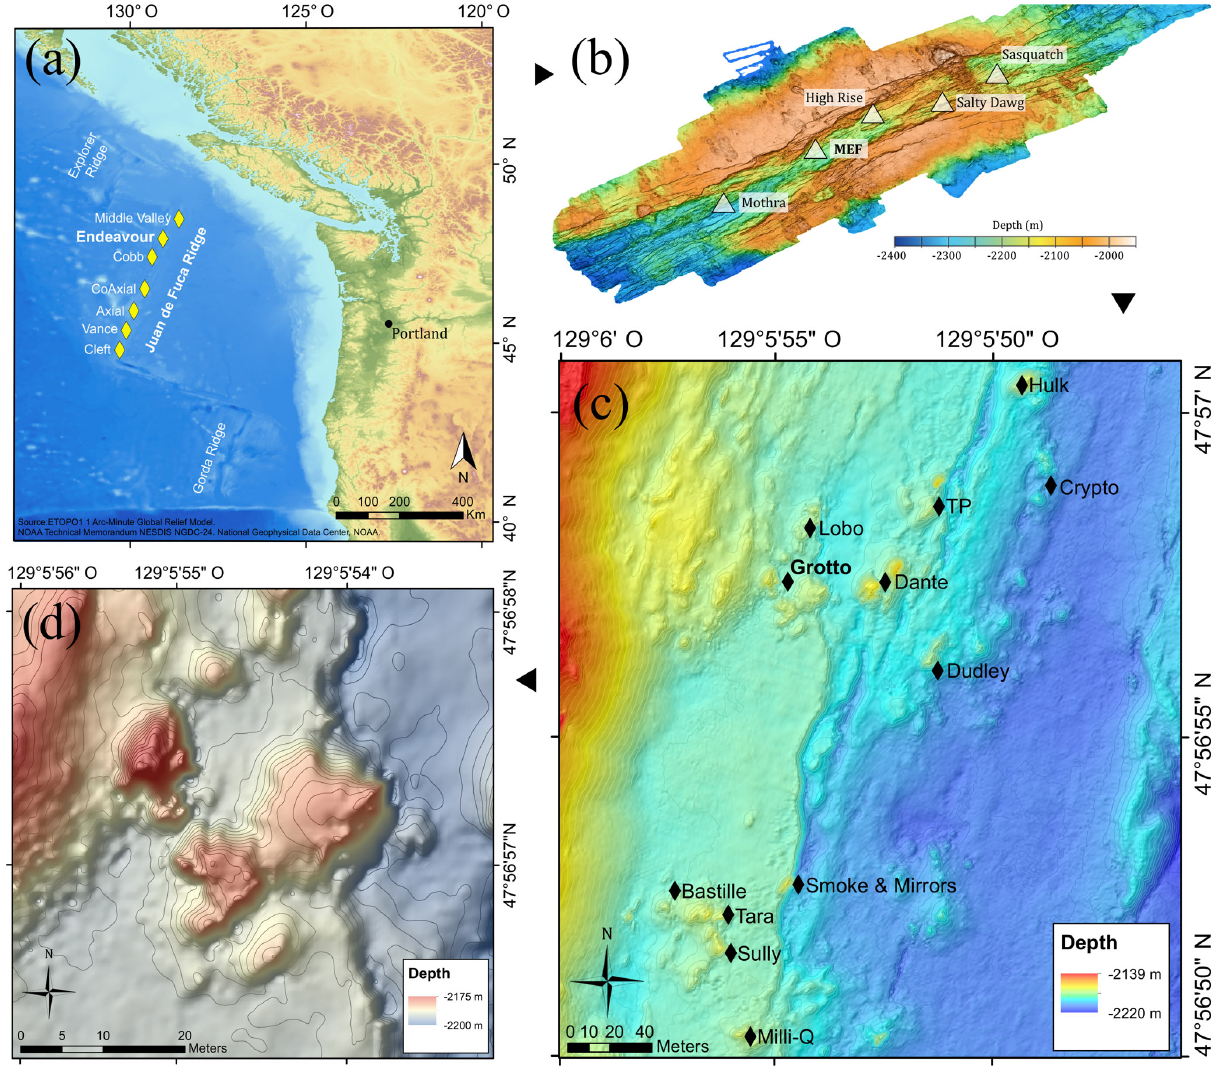
Figure 1. (a) Location of the Juan de Fuca Ridge system and the seven segments (yellow diamonds). (b) High-resolution bathymetric map of the Endeavour Segment, with the locations of the five main active vent fields (white triangles). (c) Location map of the Main Endeavour vent field indicating the positions of hydrothermal vent edifices (black diamonds). (d) Bathymetric map of the Grotto active hydrothermal edifice (47 ◦ 56.958 (cid:48) N, 129 ◦ 5.899 (cid:48) W). The 10m high sulfide structure is located in the Main Endeavour vent